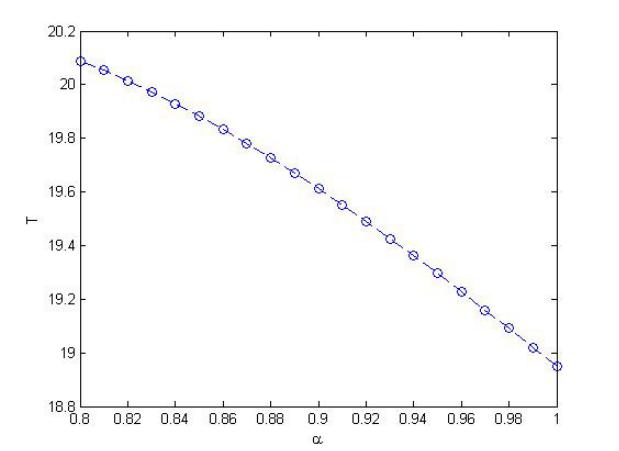
Figure 3. State trajectories of fractional-order Lorenz Systems (24) and (25) when order α = 0.9: ( a ) signals x 1 and x 2 ; ( b ) signals y 1 and y 2 ; ( c ) signals z 1 and z 2 ; ( d ) state trajectories of the error signals e 1 , e 2 , e 3 .